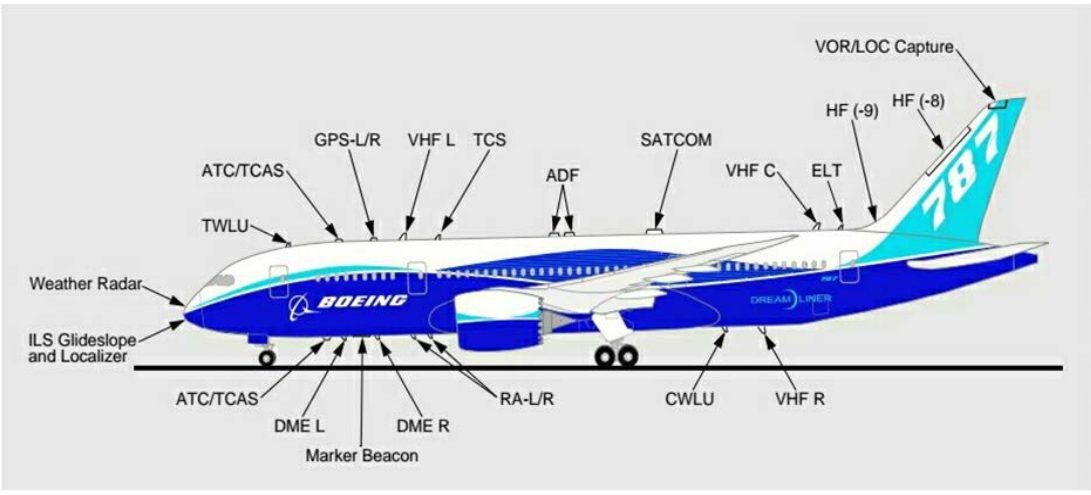
Figure 1: Typical navigation and communication antennas locations of the Boeing 787 aircraft [11].